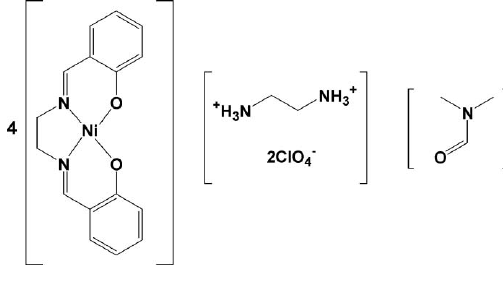
Key indicators: single-crystal X-ray study; T = 200 K; mean (cid:2) (C–C) = 0.005 A˚; disorder in solvent or counterion; R factor = 0.039; wR factor = 0.110; data-to- parameter ratio = 14.0.